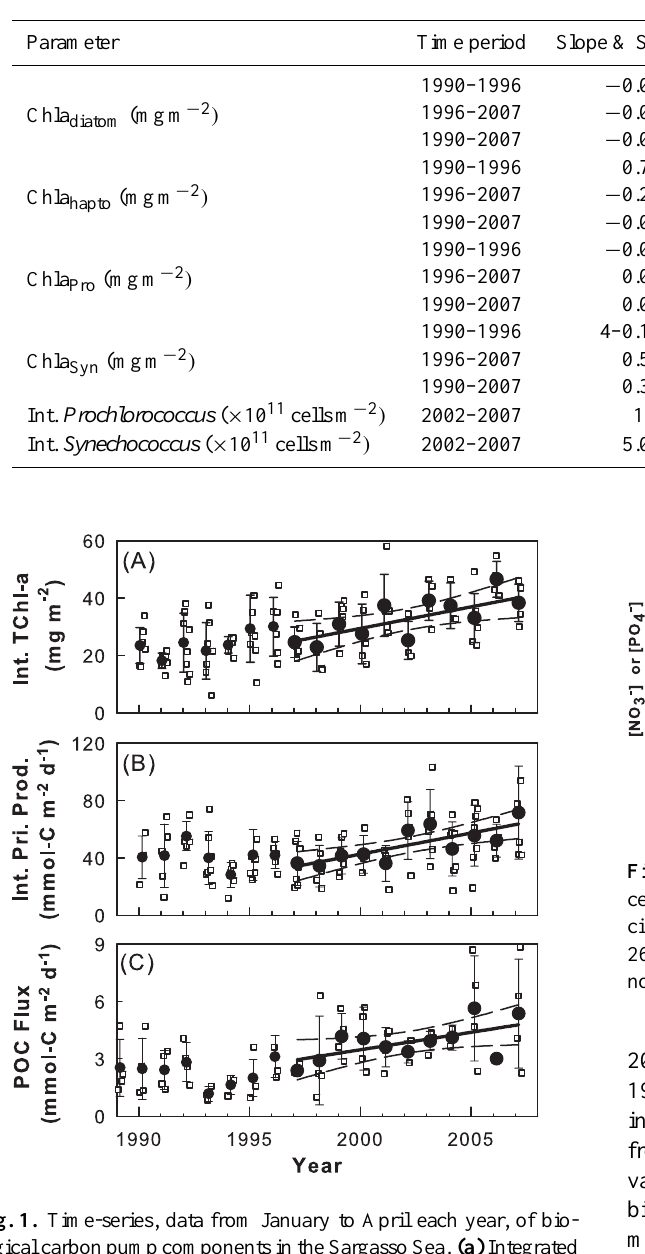
Table 3. Rates of change in phytoplankton composition parameters in the Sargasso Sea. Statistics provided for the entire period, as well as divided up into the two periods of interest as defined by the phase of the winter NAO index. n/s =no significant change. Data in the “Period Change” column are given as the absolute change in appropriate units and as percent increase from the beginning of the time period.